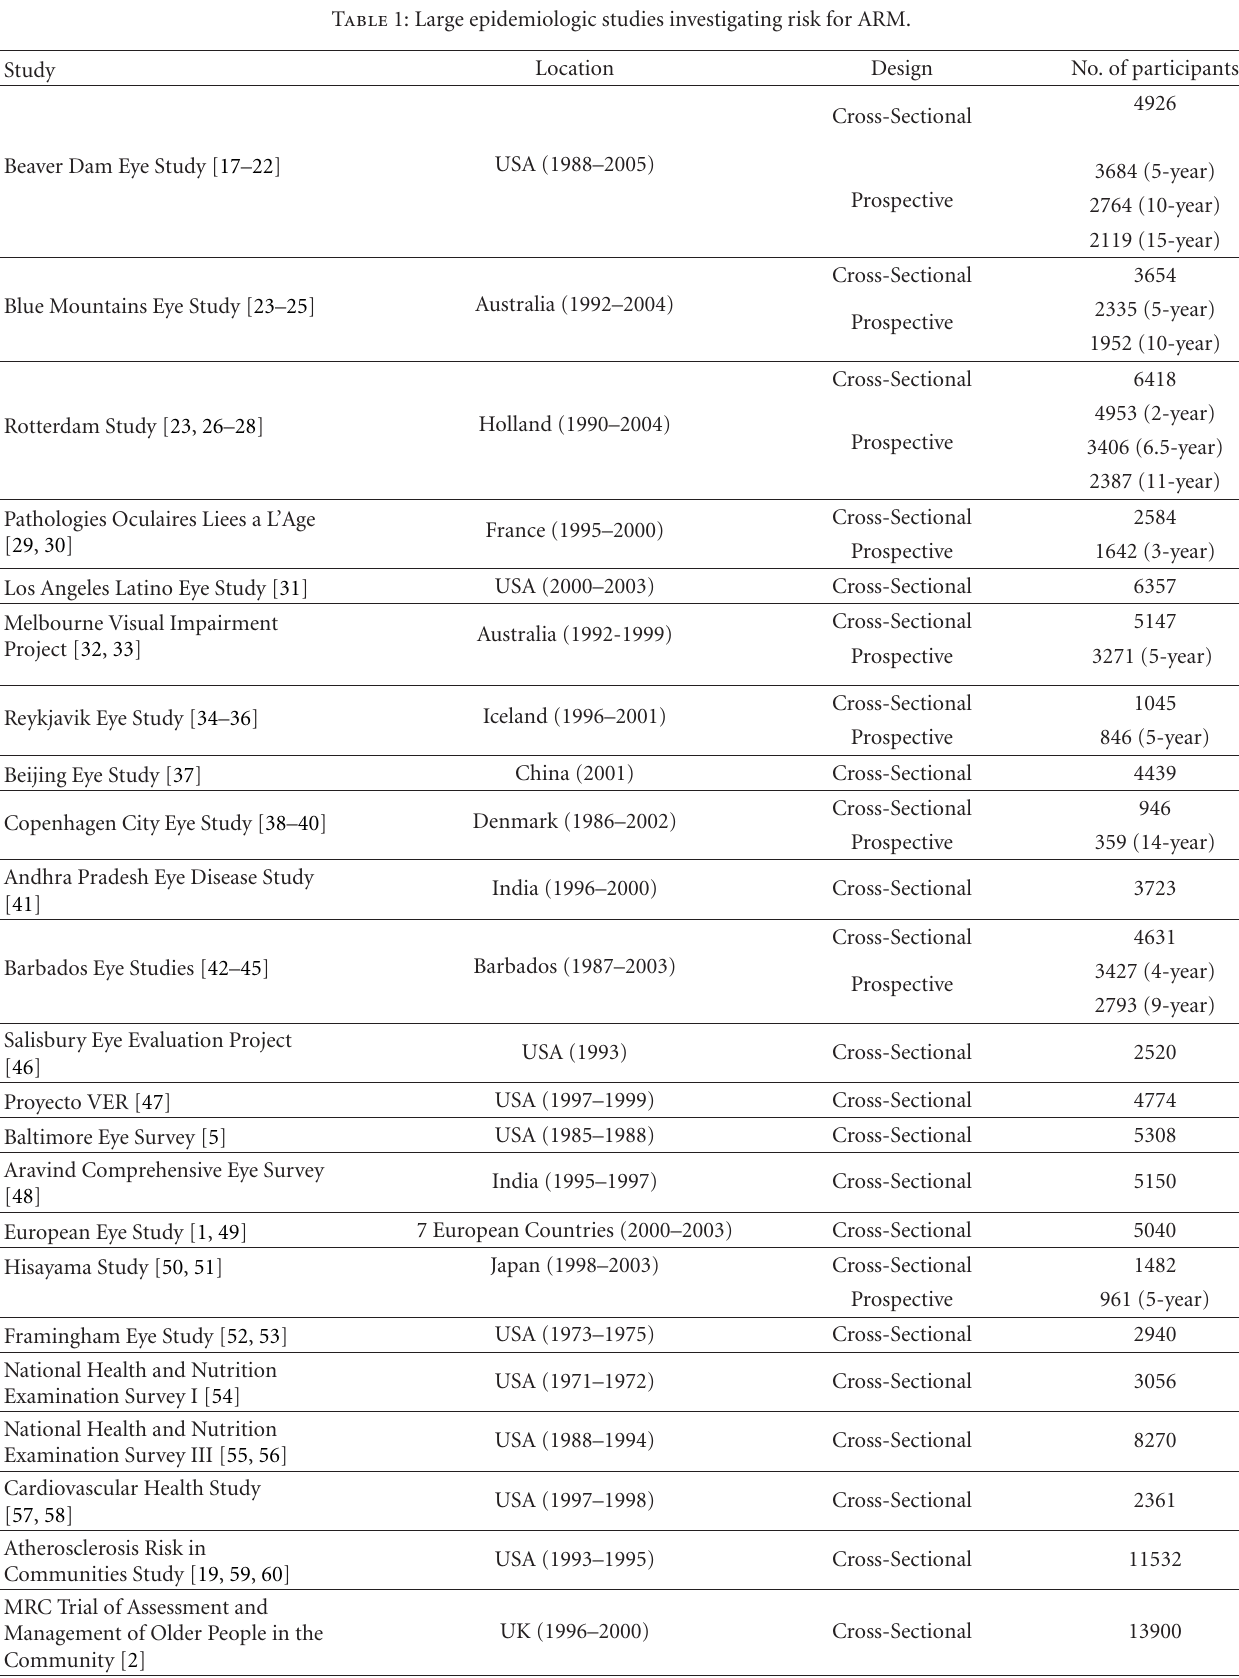
Table 1: Large epidemiologic studies investigating risk for